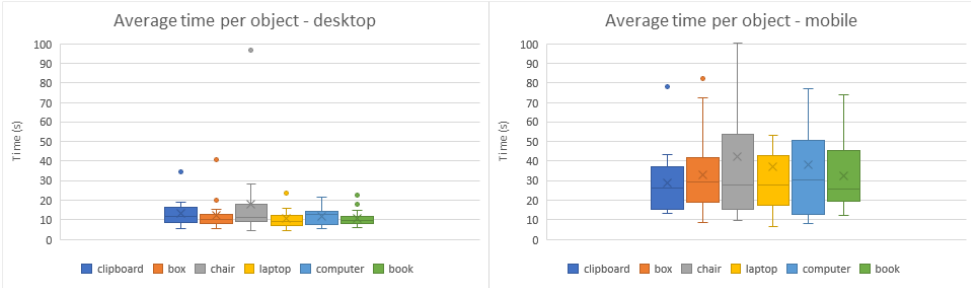
Figure 11. Box plots of the average time it took to place each virtual object in the desktop ( left ) and mobile ( right )